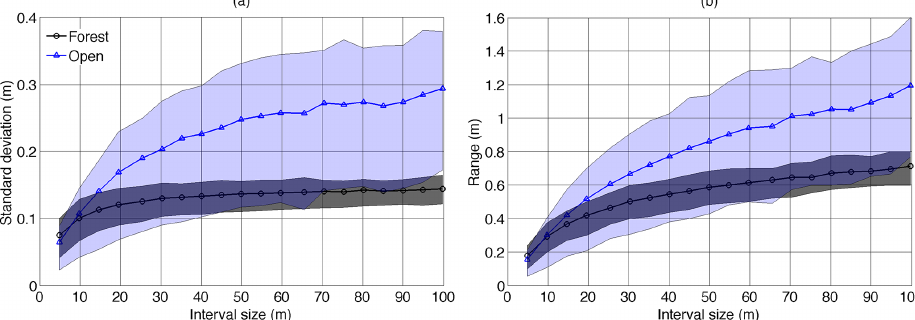
Figure 4. Sub-interval standard deviation (a) and range (b) for varying interval lengths for profiles of snow depth in a forested environment (FS) and an open and wind-influenced environment (RW) in the Colorado Rocky Mountains (same regions as those in Figs. 2 and 3). The mean standard deviation and mean range for the study areas are shown by the solid lines, while the shaded areas cover the quantiles between 25 and 75% of the values for all the intervals in these